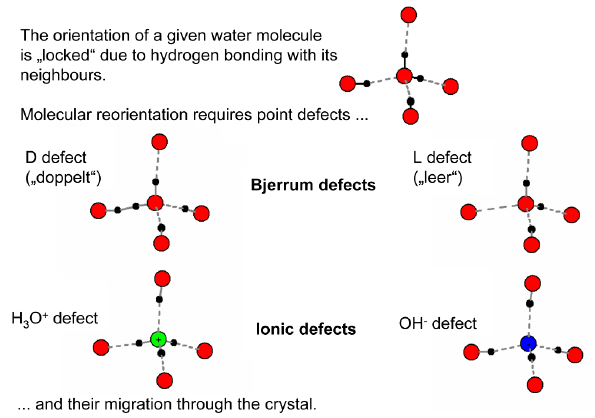
FIG. 4 (color online). Possible point defects in ice structures. Fig. 11. Sketch of possible point defects in ice. Reproduced from Bartels-Rausch et al.